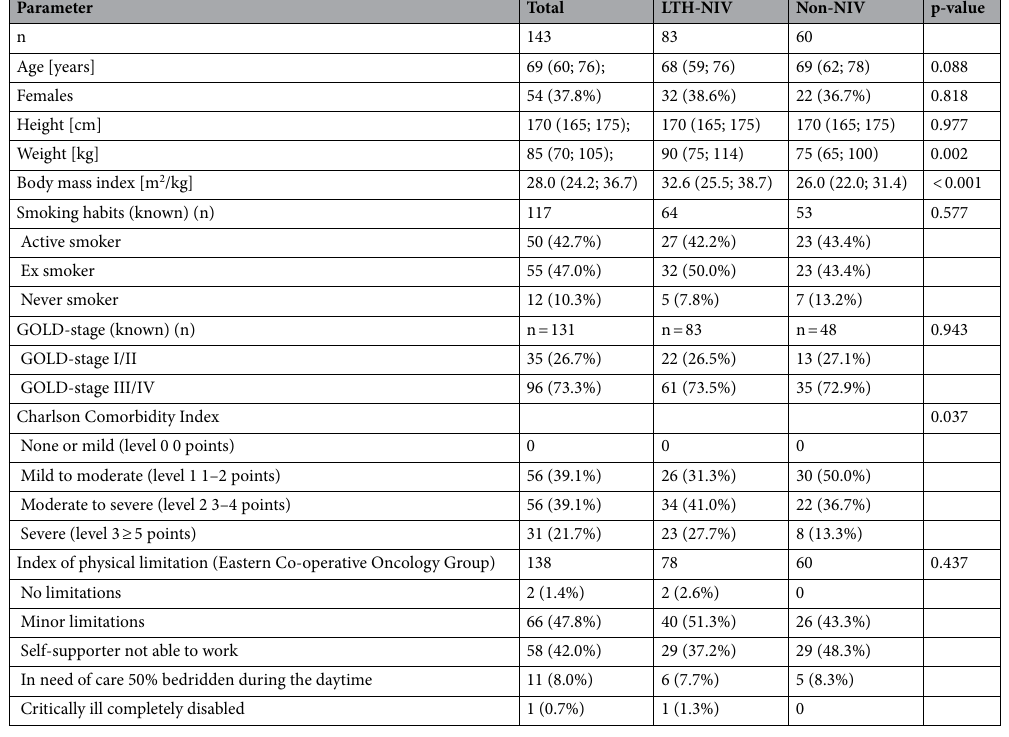
Table 1. Patient